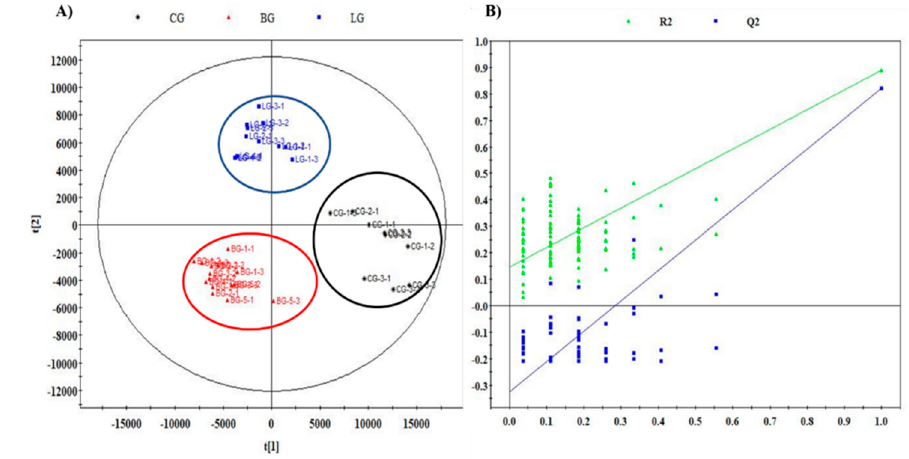
Figure 2. The PLS-DA plot and cross-validation of the three citrus blend black tea groups. ( A ) PLS-DA plot (R 2 Y = 0.907, Q 2 = 0.836); ( B ) Cross-validation of PLS-DA model with 100 permutation tests (R 2 = 0.147, Q 2 = − 0.324).